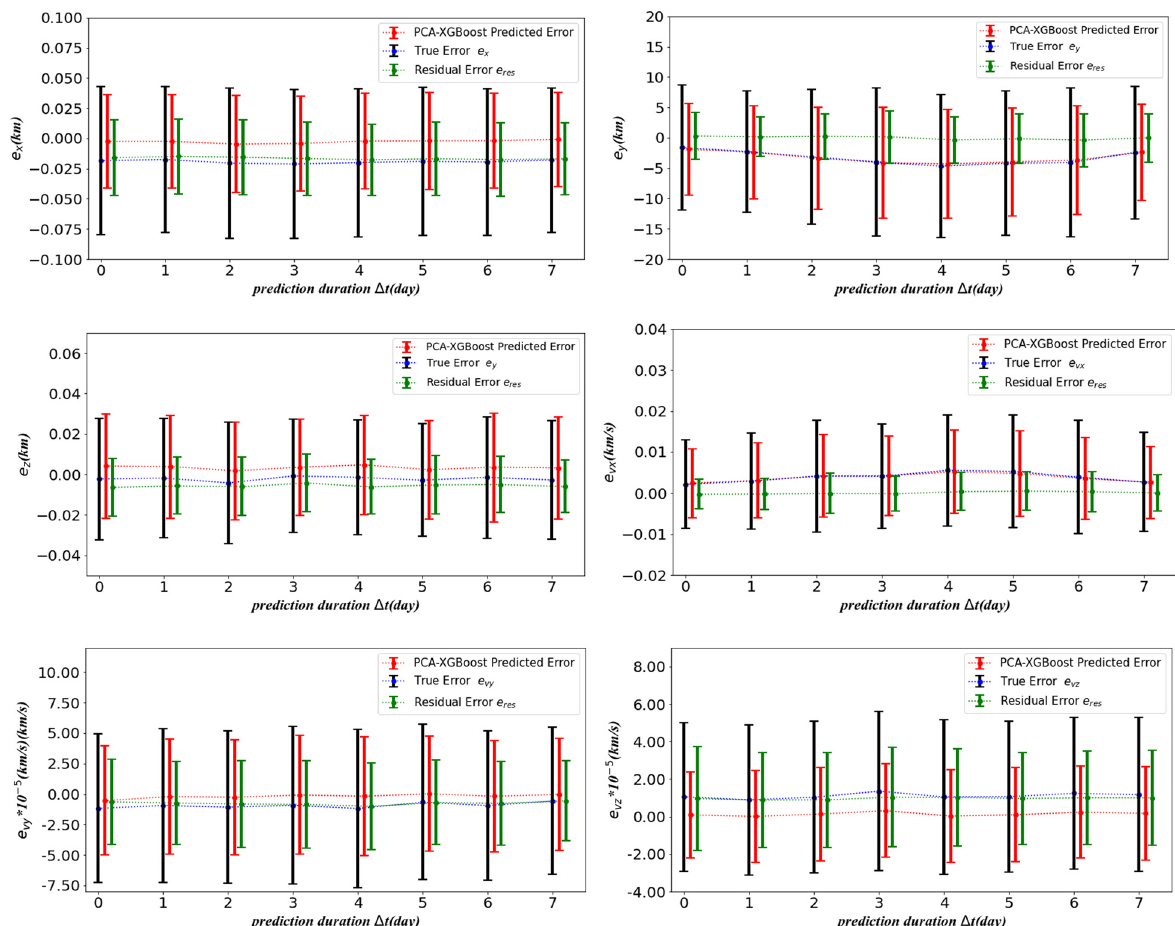
Figure 4: Performance of PCA – XGBoost model on training dataset. ( a ) = P 6.47% , ( b ) = P 2.29% , ( c ) = P 6.96% , ( d ) = P 2.94% , ( e ) = P 3.08% , and ( f ) = P 7.24% .